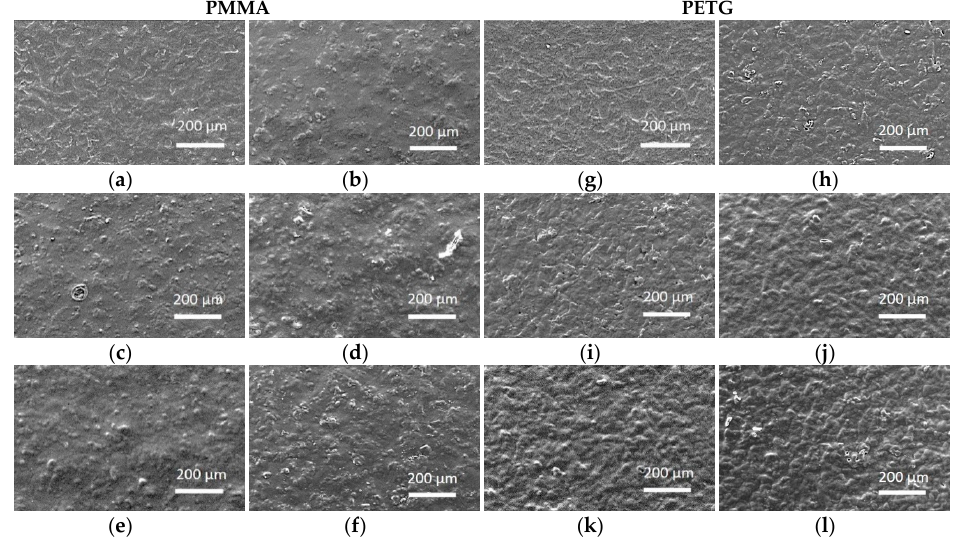
Figure 8. Scanning electron microscopy (SEM) images showing CS coating: PMMA after coating ( a ); PMMA control group L0 ( b ); PMMA L1 ( c ); PMMA L2 ( d ); PMMA L3 ( e ); PMMA L4 ( f ); PETG after coating ( g ); PETG control group L0 ( h ); PETG L1 ( i ); PETG L2 ( j ); PETG L3 ( k ); PETG L4 ( l ).